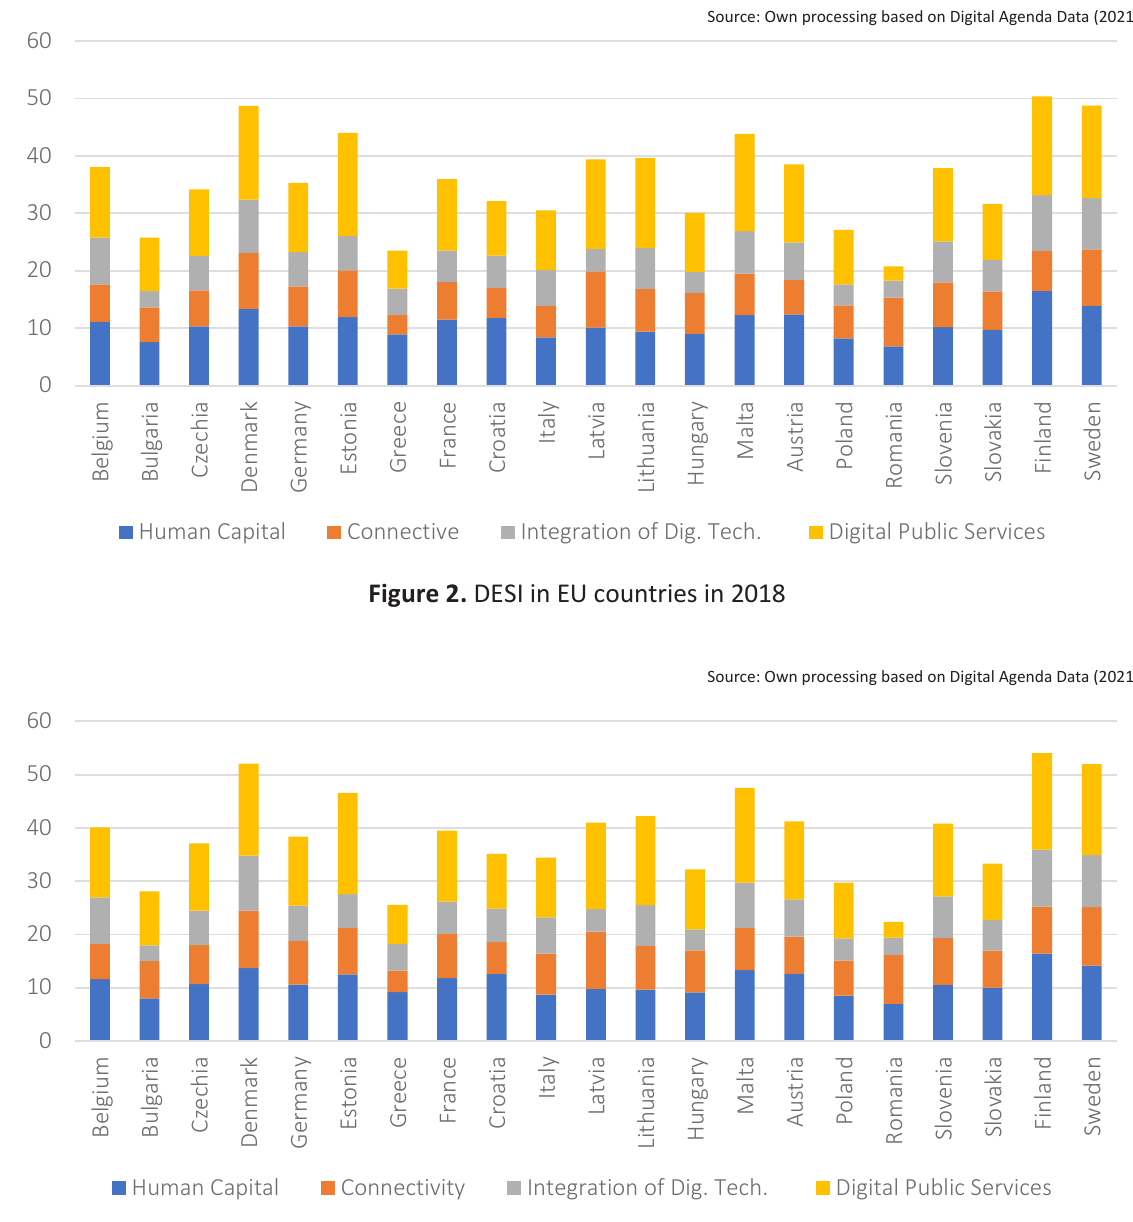
Figure 3. DESI in EU countries in